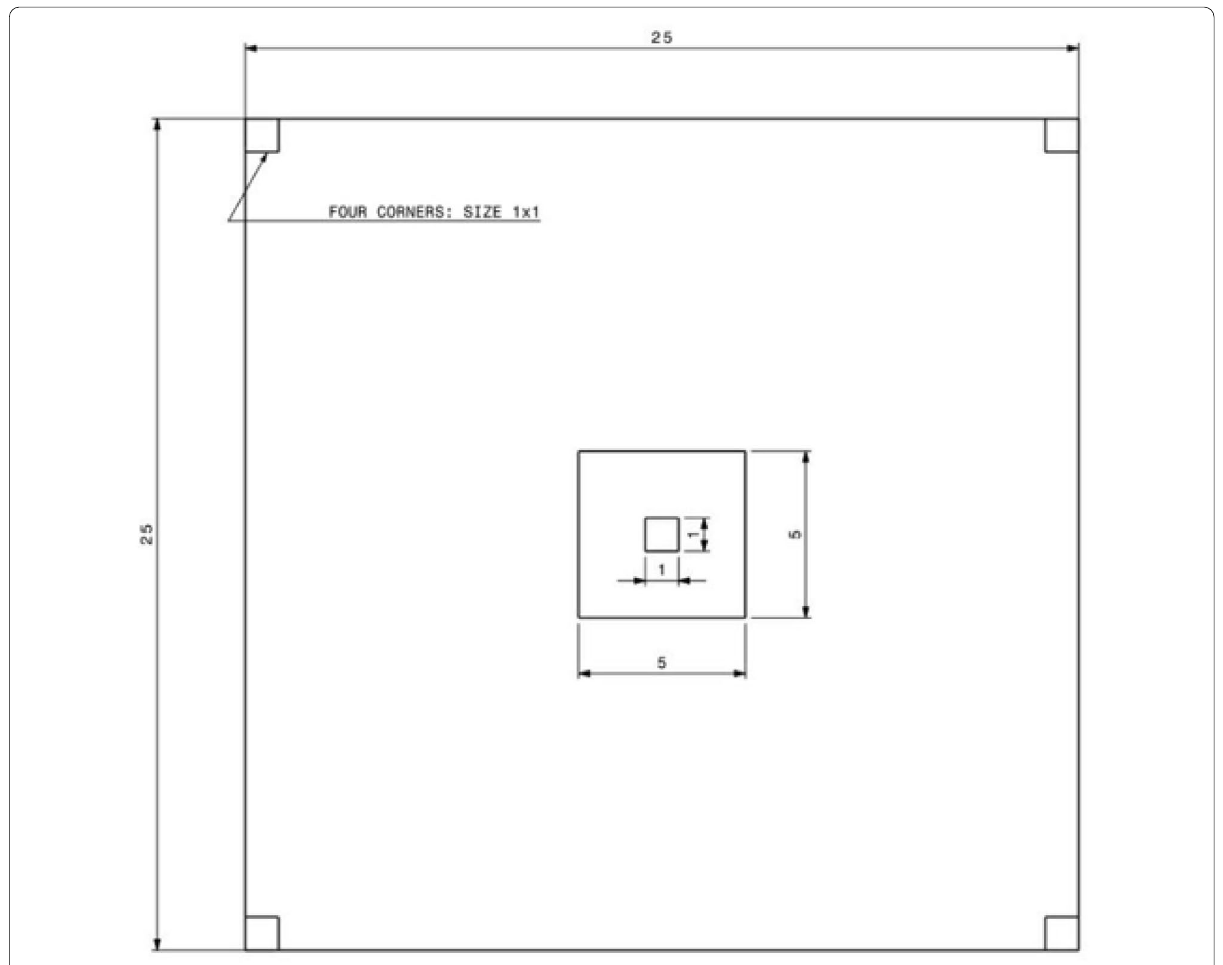
Fig. 3 Design of plot layout in the study area (unit in meter, scale